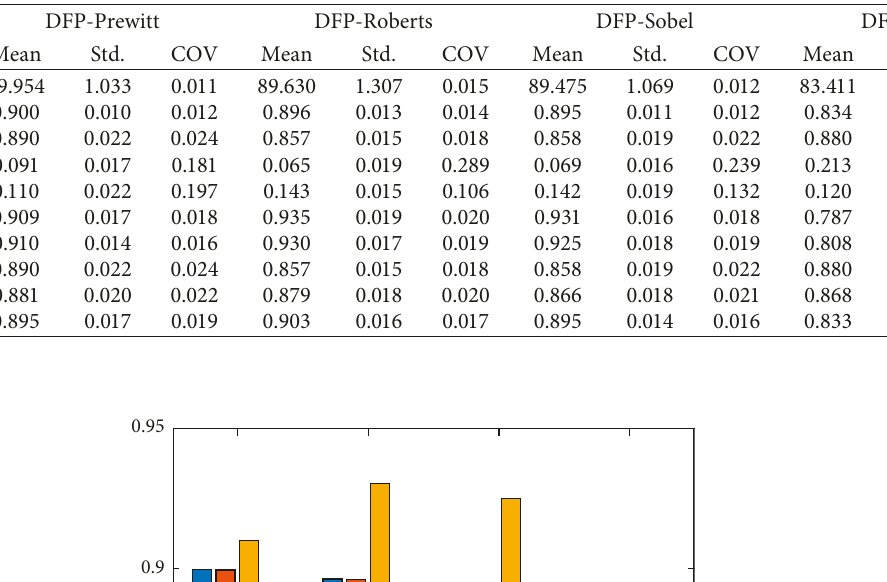
Table 2: Classification result comparison.